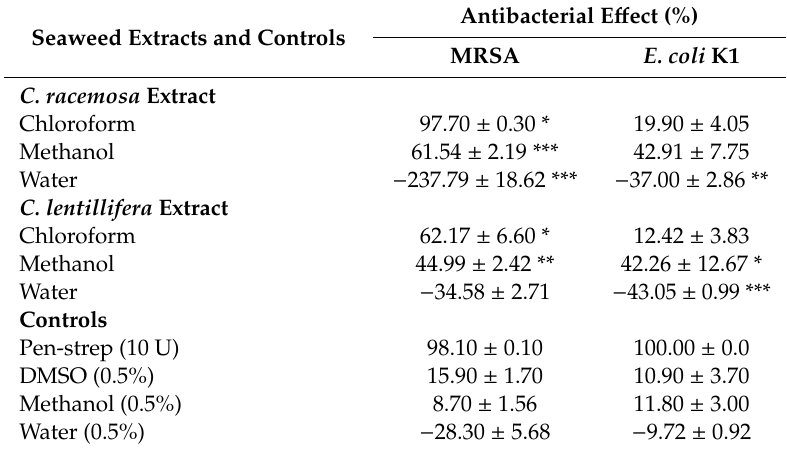
Table 4. Percentage of antibacterial effect of seaweed crude extracts against MRSA and E. coli K1. Seaweed Extracts and Controls